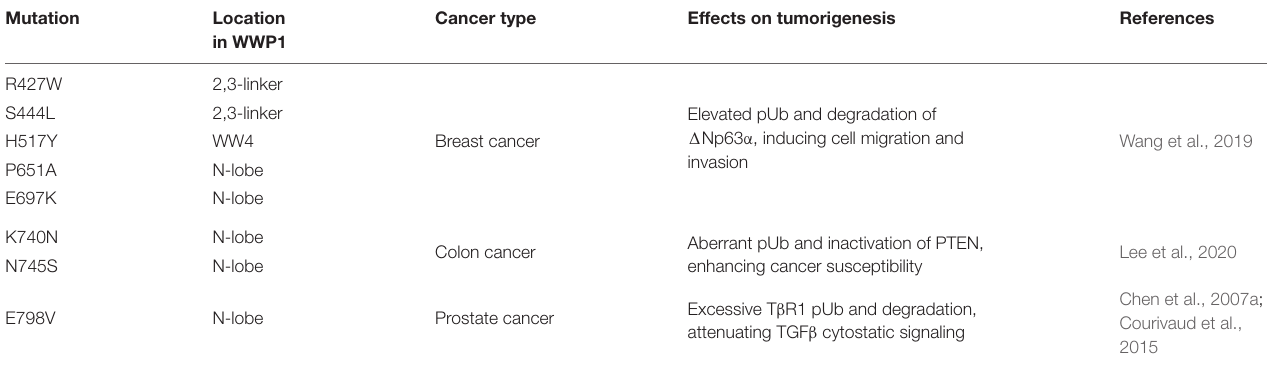
TABLE 3 | Validated hyperactive WWP1